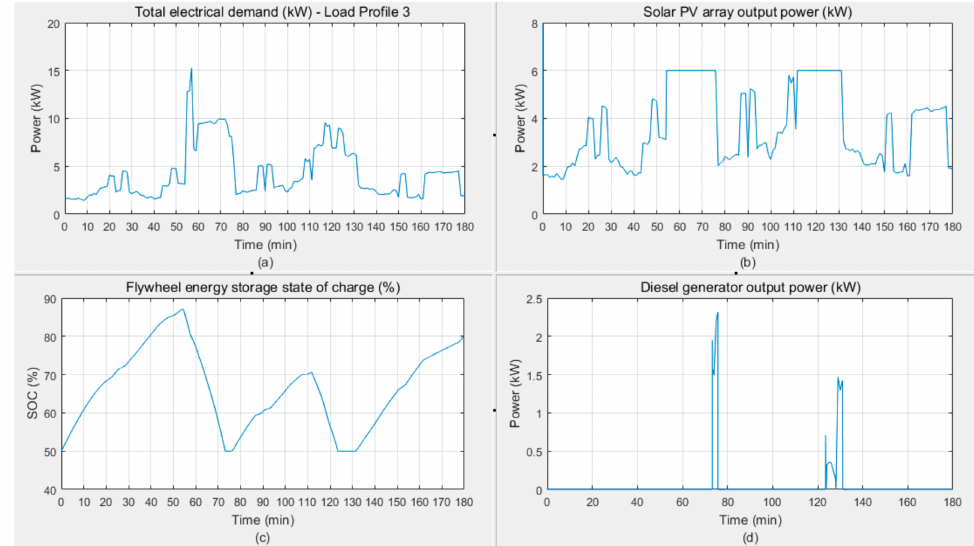
Figure 25. ( a ) Load profile 3. ( b ) PV array output power. ( c ) Flywheel initially at 50% state of charge. ( d ) Diesel generator output power.